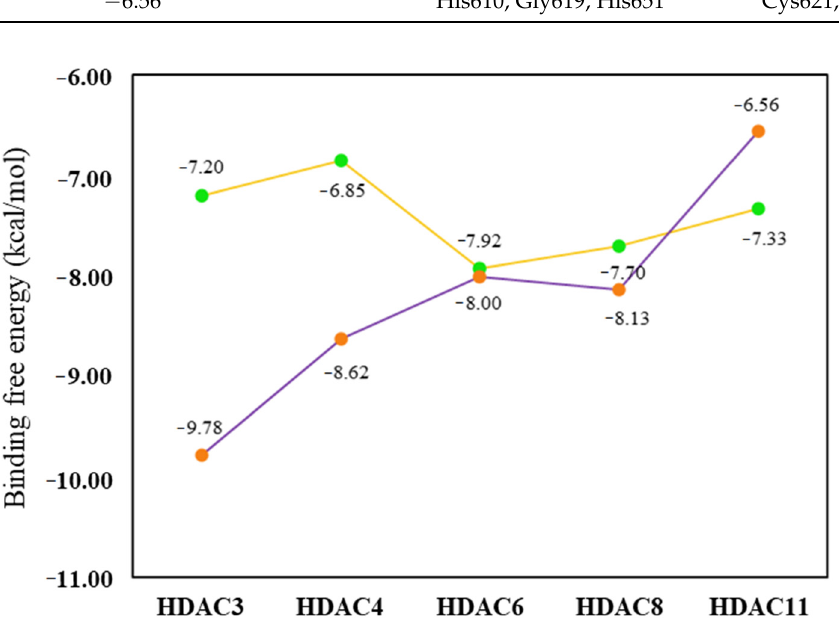
Figure 6. Plot of ligand binding free energy between compound 8 (yellow line and green dot) and Belinostat (purple line and orange dot) toward studied HDAC enzymes. Table 3. Docking results of studied compounds and hydrogen bond interacting residues.